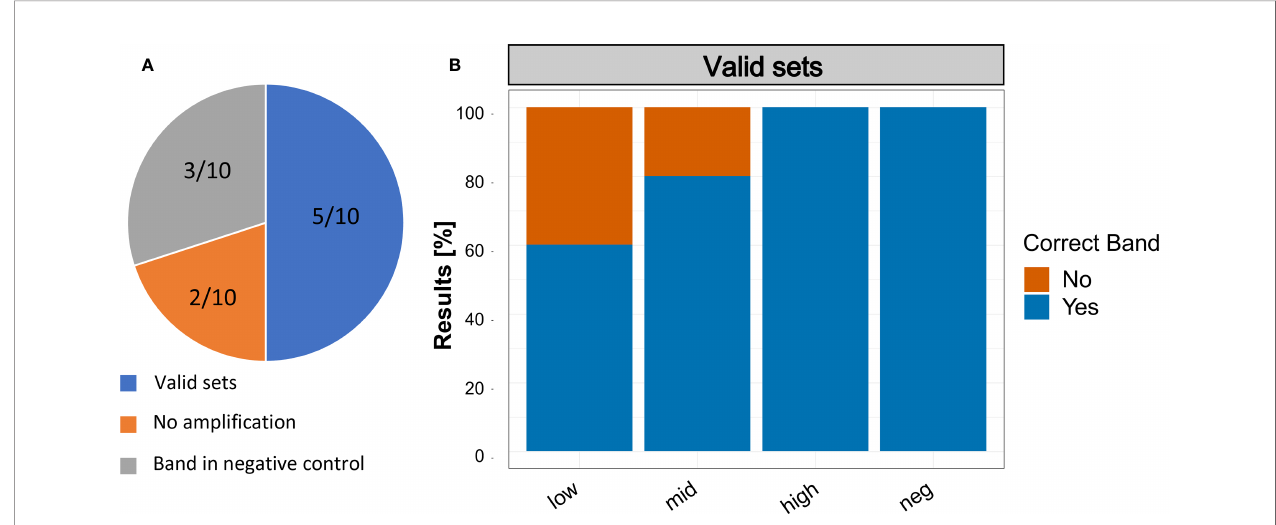
Based on the useability assessment performed after the validation trial ( Figure 8 ), the clarity and ease of use values ranged mainly between 3 and 5 (i.e., medium to very easy/clear).